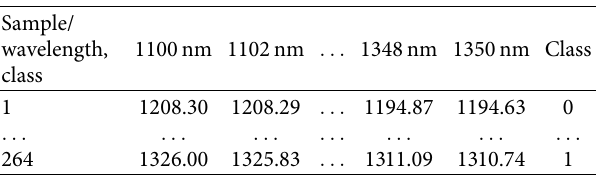
Table 4: A visual representation of the transformed data (all samples, sensor